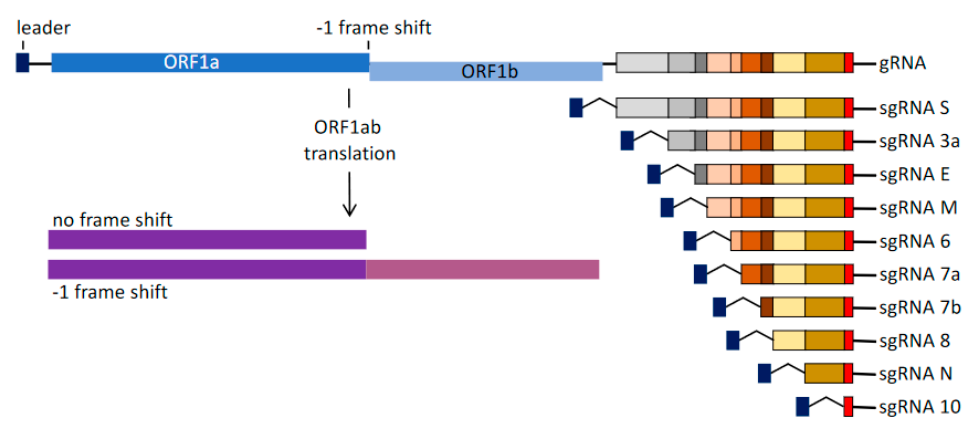
Figure 2. SARS-CoV-2 genomic (gRNA) and subgenomic RNA (sgRNA) structures. − 1 FS indicates the site of − 1 frameshifting.